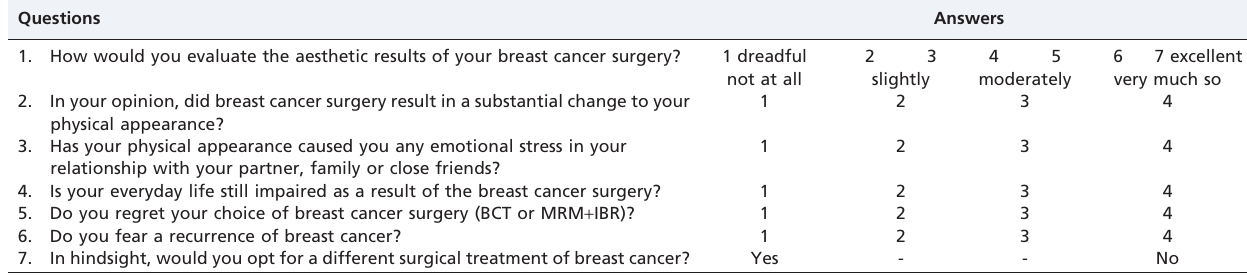
Table 1 - Questions used to investigate patient satisfaction with breast cancer surgery.